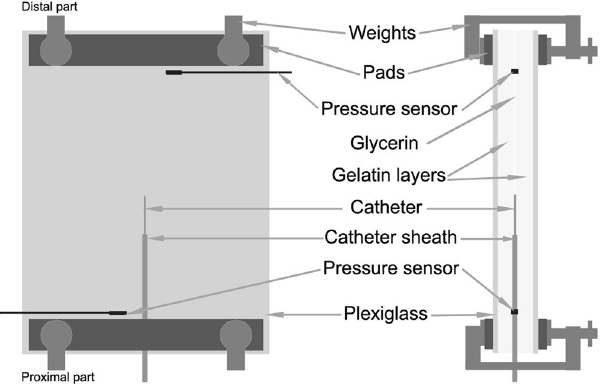
Figure 3. Schematic description of the experimental setup for the simulation of embryo